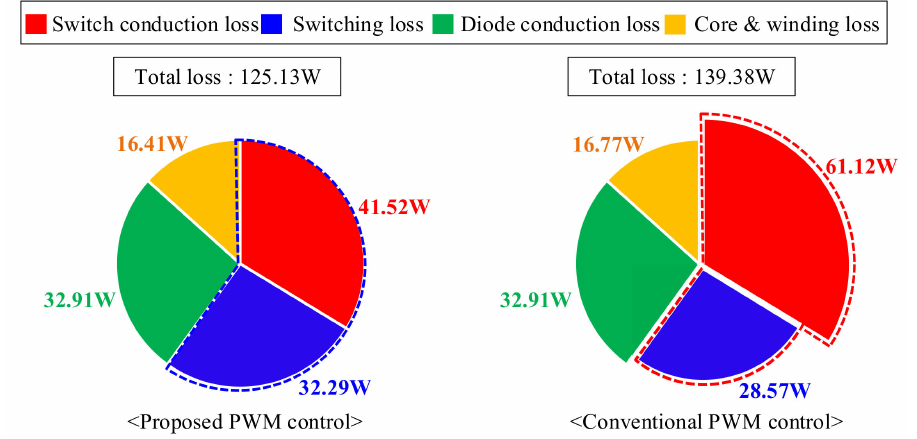
Figure 18. Loss analysis under the full load condition with PWM